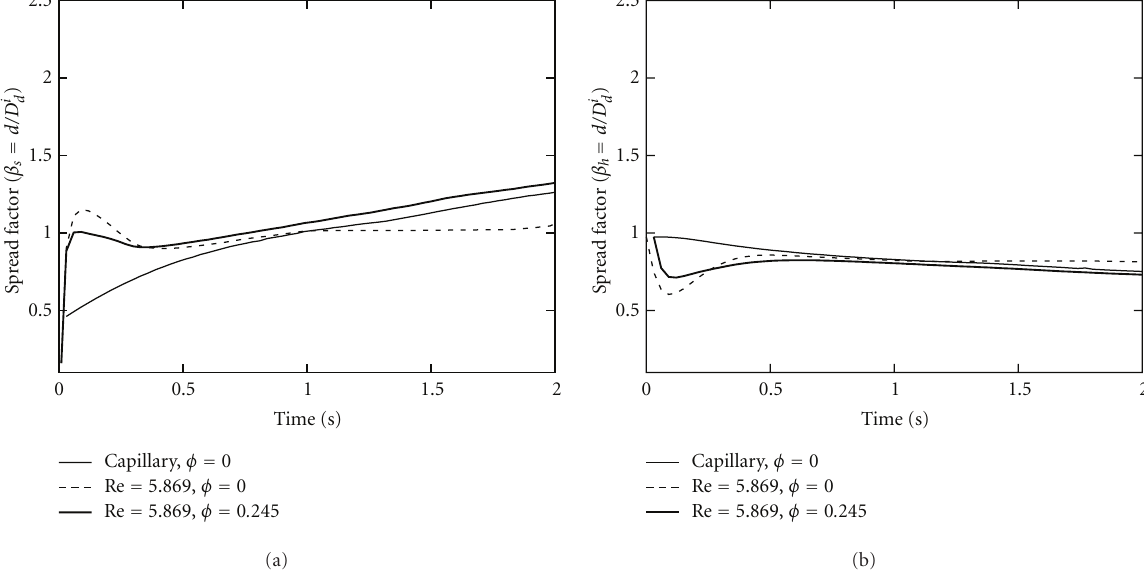
Figure 7: The comparison of time evolutions of (a) the spread factor β s and (b) the splat height β h for capillary and inertial spreading with the presence or absence of